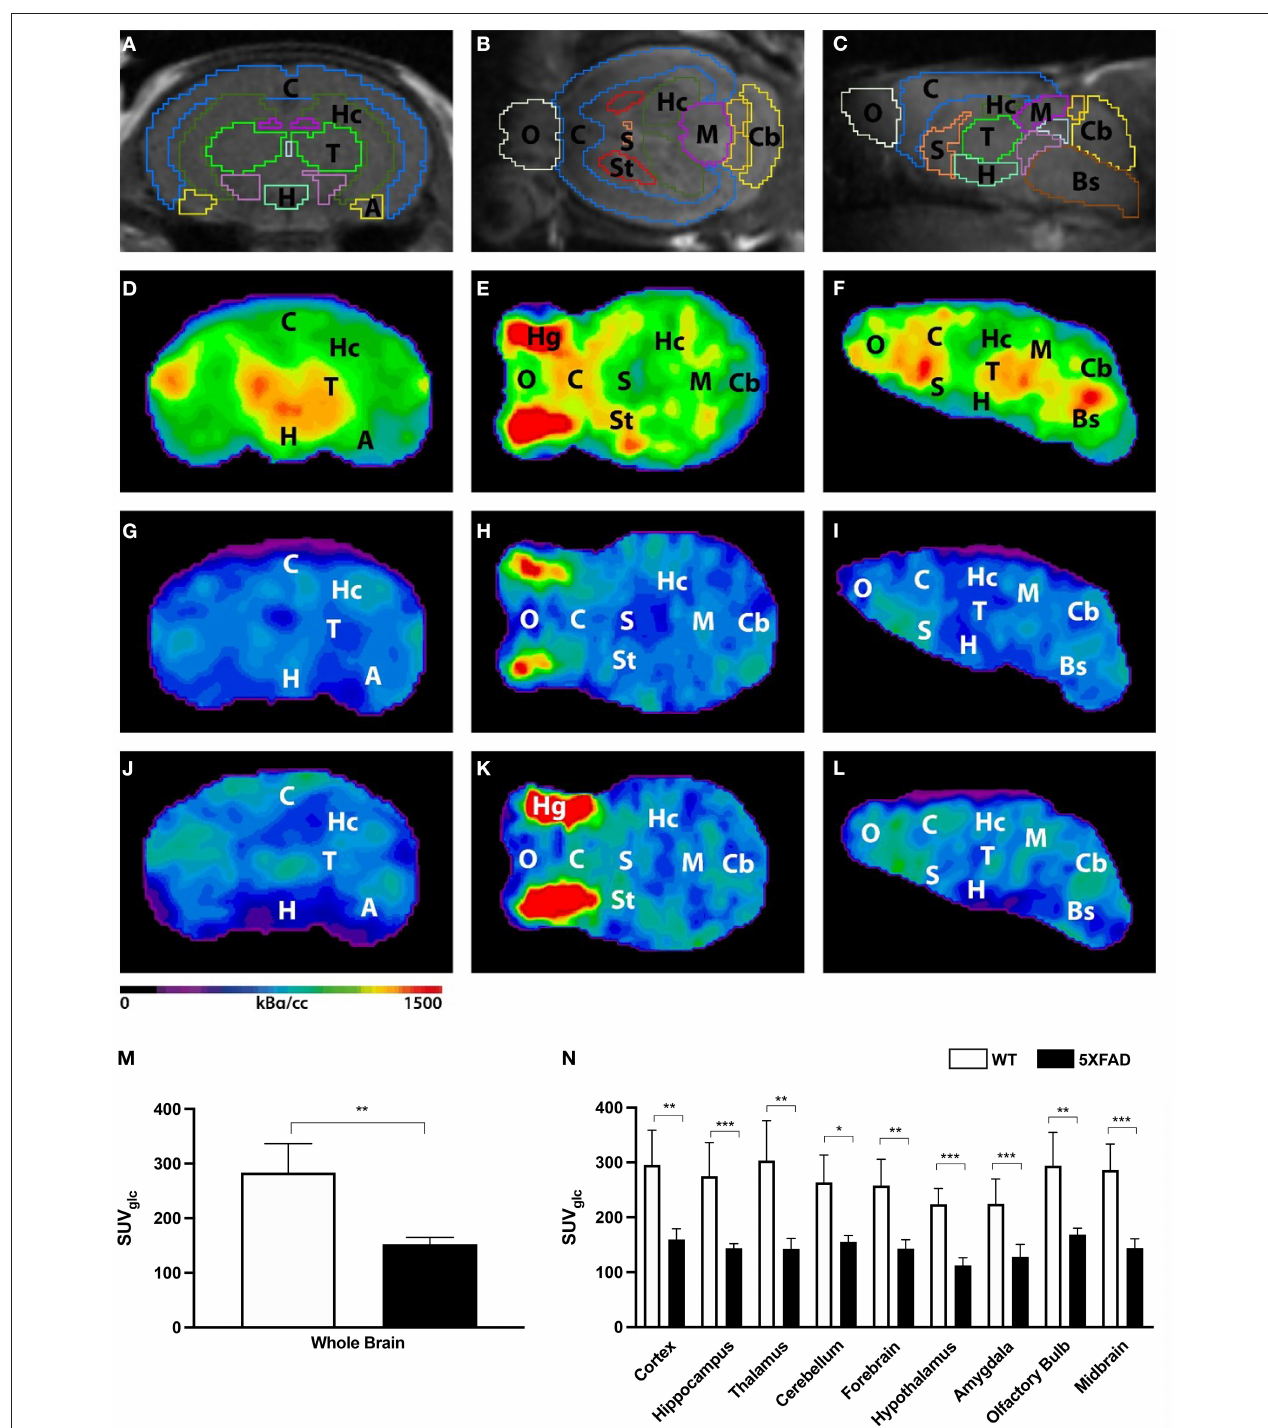
FIGURE 1 | 18F-FDG uptake in 7-month-old female 5XFAD mice and age- and sex-matched WT mice. (A–C) Mouse brain atlas with predefined brain regions projected on MRI images in coronal, transverse, and sagittal view. (D–F) Exemplary 18F-FDG-PET images of a 7-month-old female WT mouse. (G–I) 18F-FDG-PET images of a 7-month-old female 5XFAD mouse. (J–L) 18F-FDG-PET images of a 7-month-old male 5XFAD mouse. Seven-month-old female and male 5XFAD mice show significantly lower 18F-FDG uptake compared to WT mice. (M) 7-month-old female 5XFAD mice showed significantly lower SUVglc in the whole brain compared to 7-month-old female WT mice. (N) Differences could be detected in all brain regions. A, Amygdala; Bs, Brain Stem; C, Cortex; Cb, Cerebellum, H, Hypothalamus; Hc, Hippocampus; Hg, Harderian Glands; M, Midbrain; O, Olfactory Bulb; S, Septum/Basal Forebrain; St, Striatum; T, Thalamus. Unpaired t -test; * p < 0.05, ** p < 0.01, *** p < 0.001; data presented as mean + /- SD.